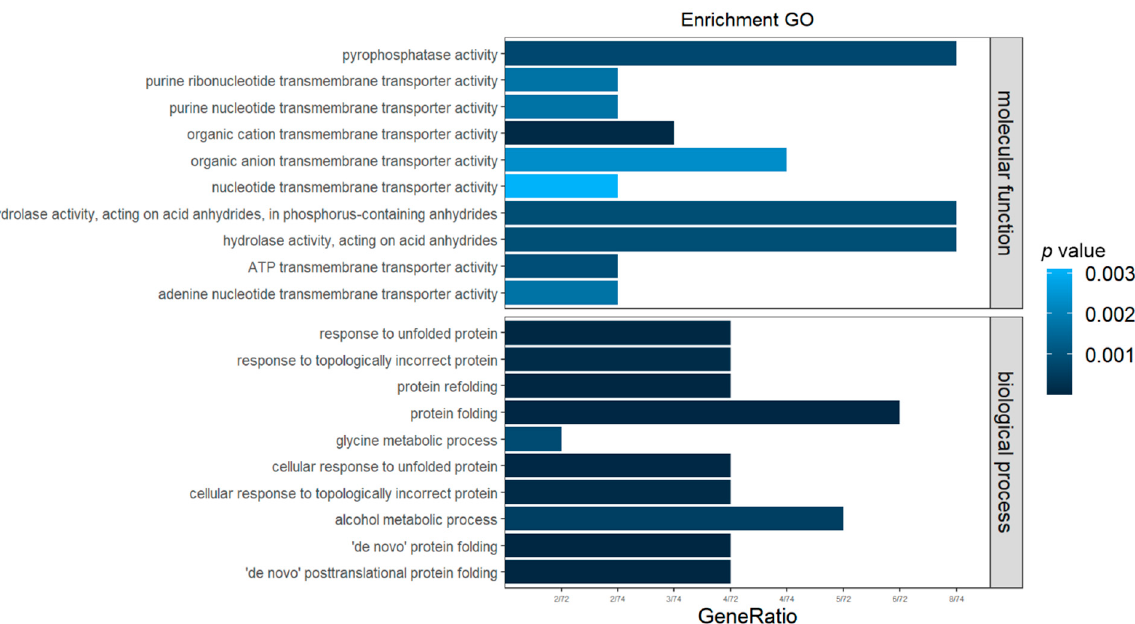
Figure 3. KEGG enrichment analysis. 4. Discussion 4.1. The Effect of Flow Velocity on Fish Growth Water velocity is an important physicochemical factor that regulates the process of fish growth and development. It can change the frequency of fish swimming, enhance metabolic activity, and regulate its physiological functions, thereby affecting nutrient intake, growth, and development [13]. A previous study found that the weight gain rate